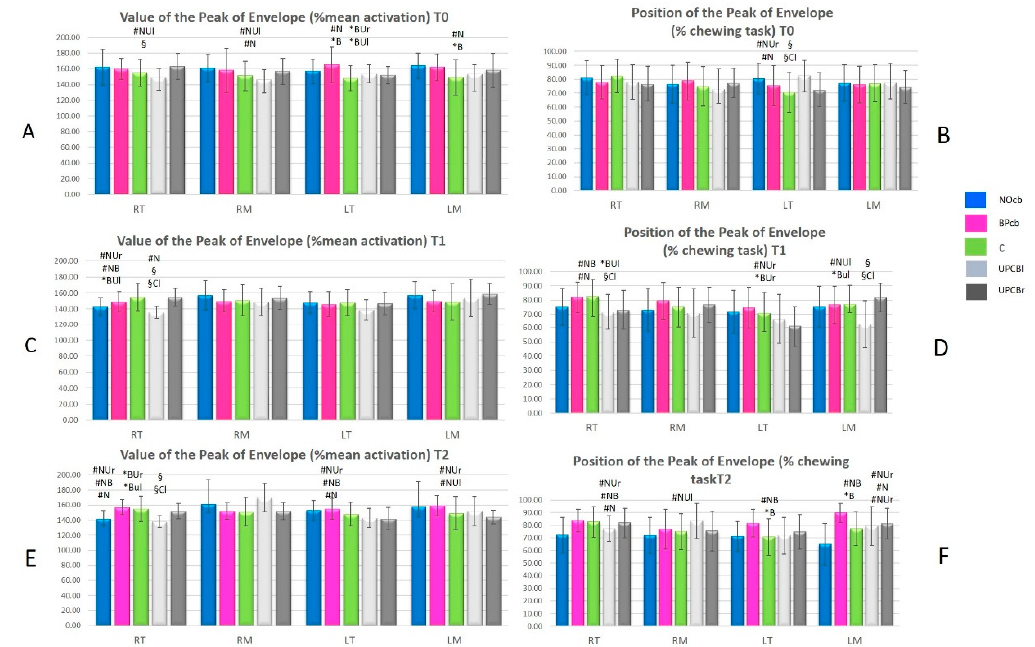
Figure 2. the results of one-way ANOVA (p < 0.05) at T0 ( A , B ), at T1 ( C , D ), at T2 ( E , F ) between the 5 populations. Color Legend: blue for NoCB, pink for BPcb, green for Controls, light grey for UPCBl and grey for UPCBr.